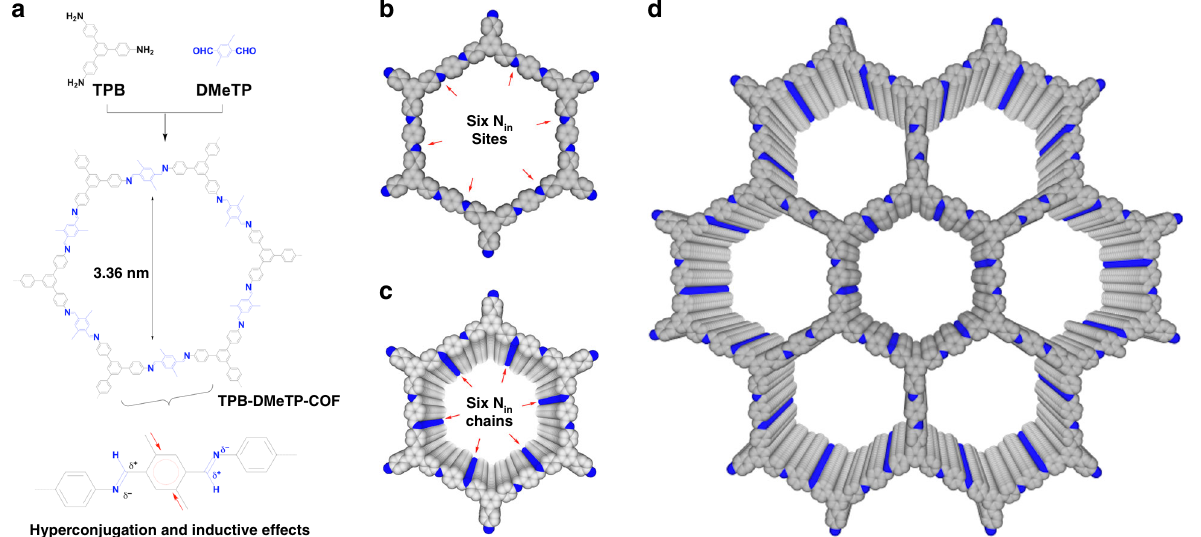
Fig. 1 Stable covalent organic frameworks with dense 1D nanochannels. a Topology-guided synthesis of a stable crystalline mesoporous TPB-DMeTP- COF with a pore size of 3.36 nm. Inset shows the inducive and hyperconjugation effects of methyl groups that reduces the polarisation of C = N bonds, softens interlayer charge repulsion and yields an extremely stable framework. b Reconstructed structure of one hexagonal macrocycle (grey, C; blue, N; CH 3 units and H are omitted for clarity). One hexagon has six N in sites on each edge. c Reconstructed structure of a 1D channel; only 20 layers are shown. The 1D channel possesses six N in chains with one on each on pore walls; the N in site is separated by 3.52 Å along the z direction. d Reconstructed structure of extended and ordered 1D hexagonal nanochannels; only seven channels and 20 layers are shown. Nanochannels are independent and densely aligned across the material.